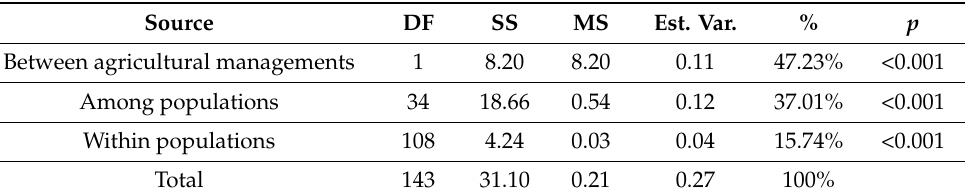
Table 6. Analysis of molecular variance (AMOVA) based on Simple Sequence Repeats in Echinochloa crus-galli . Source